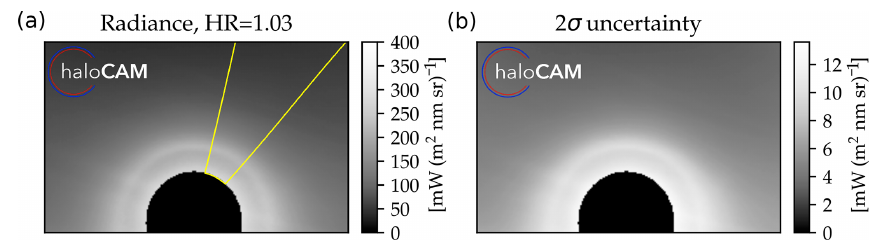
Figure 11. HaloCam RAW R channel (a) radiance and (b) 2 σ standard deviation from 21 April 2016, averaged over the period between 12:00 and 14:00UTC. The 22 ◦ halo ratio amounts to 1.03 and was calculated in the averaged azimuth segment, indicated here in yellow.